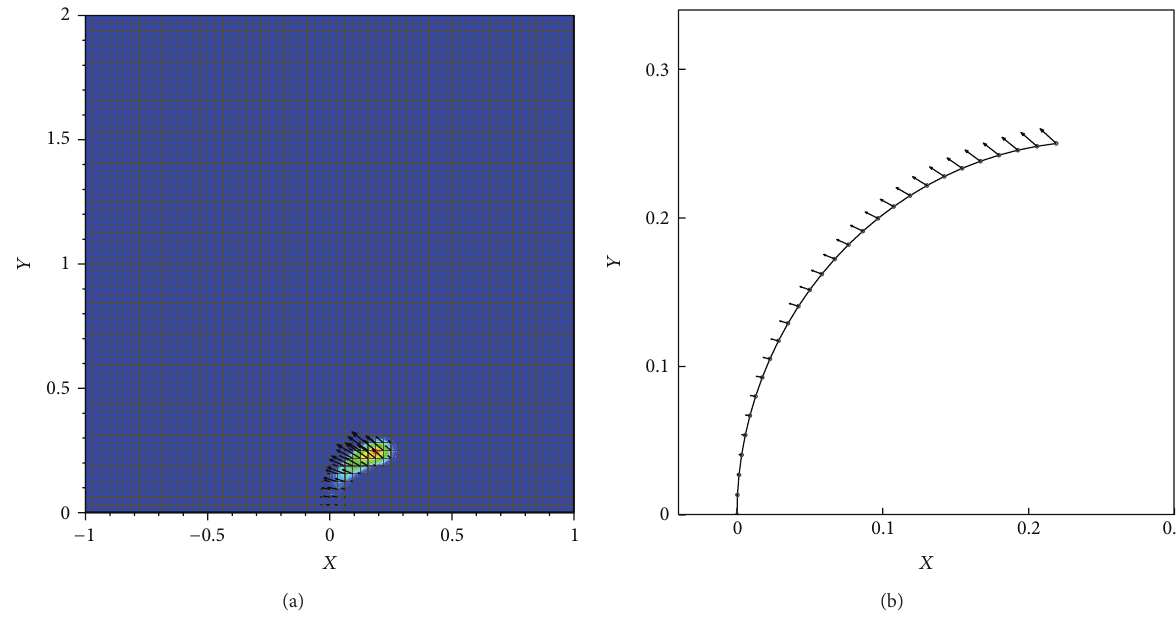
Figure 7: Eulerian (a) and Lagrangian (b) forces at 𝑡 = 0